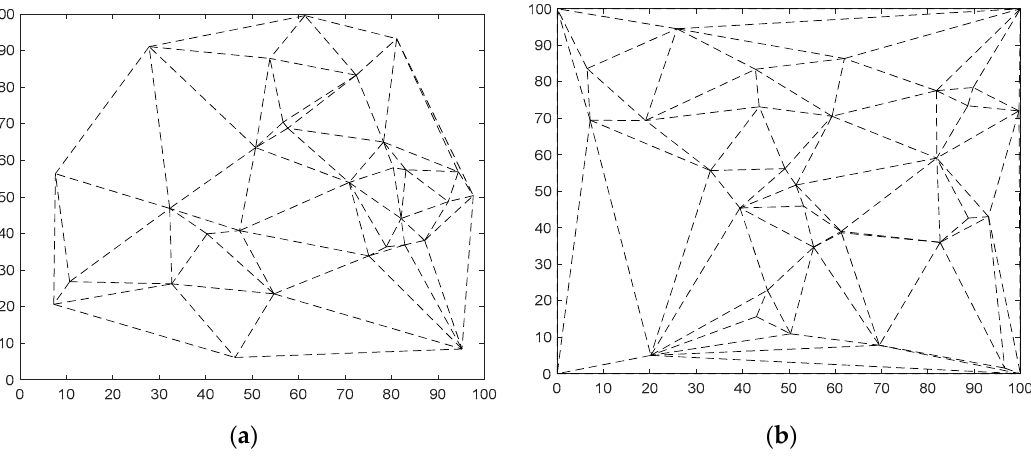
Figure 1. Triangle Network. ( a ) Delaunay triangulation of nodes; ( b ) Regional Delaunay triangula- tion.